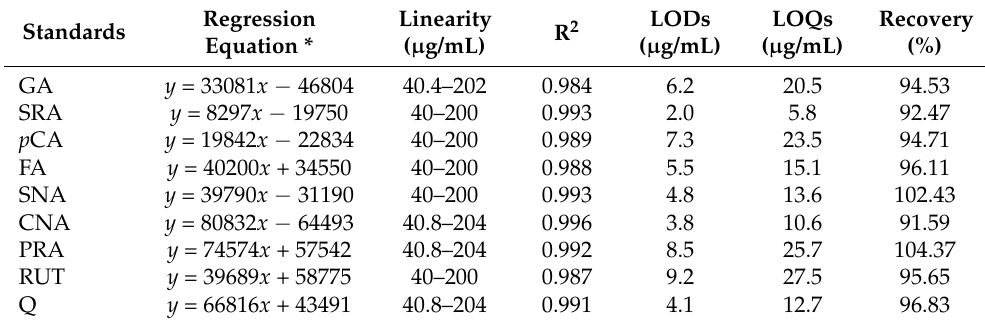
Table 1. Parameters of calibrations for the standard phenolic compounds